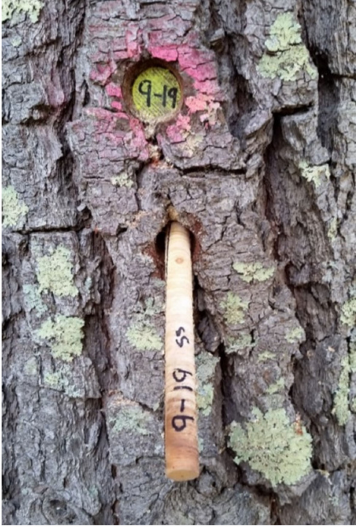
Figure 2. Twenty trees were selected as sawlogs from each site. Plugs were inserted in the outerwood core sampling hole to assist in identifying individual butt logs in the log yard, and on three trees per site full radius cores were taken for SilviScan analyses.